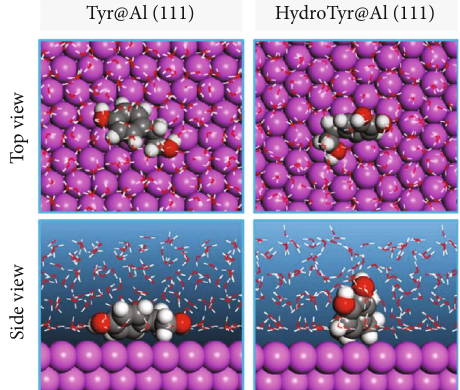
Figure 10: Top and side views of the equilibrium adsorption mode of Tyr and HydroTyr molecules onto Al(111)